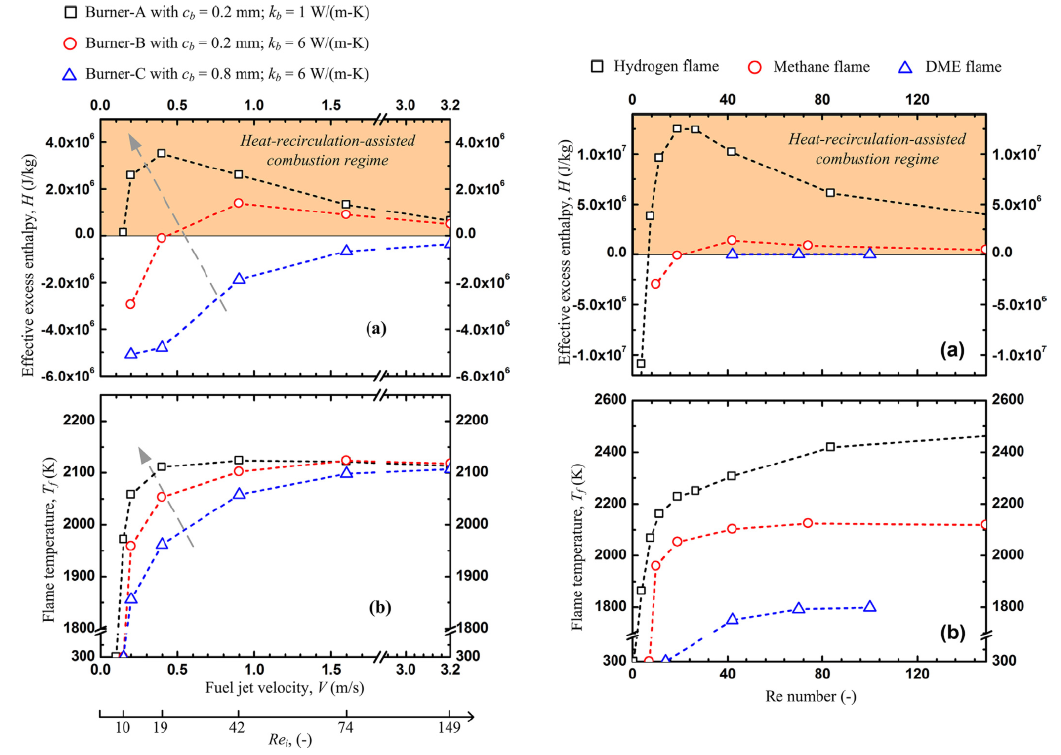
Figure 15. Numerical study on heat-recirculation assisted combustion for small scale jet diffusion flames at near-extinction condition by Gao et al. [28]. Left : Effective excess-enthalpies ( a ) and flame temperatures ( b ) over fuel jet velocities range from the extinction limits to 3.2 m/s for different burners: Burner-A with c b = 0.2 mm and k b = 1 W/(m-K), Burner-B with c b = 0.2 mm and k b = 6 W/(m-K) and Burner-C with c b = 0.8 mm and k b = 6 W/(m-K); Right : Effective excess-enthalpies ( a ) and flame temperatures ( b ) as a function of Re number for H 2 , CH 4 , and DME flames. The burner wall thickness is and the thermal conductivity is c b = 0.2 mm and k b = 6